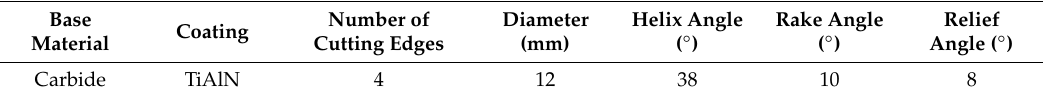
Table 3. Conditions of end milling experiments in CM and HRUEM.